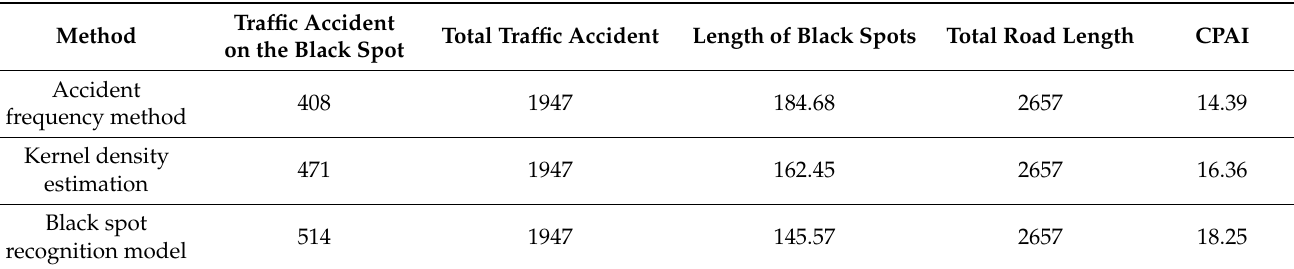
Table 5. Comparison of different identification methods.